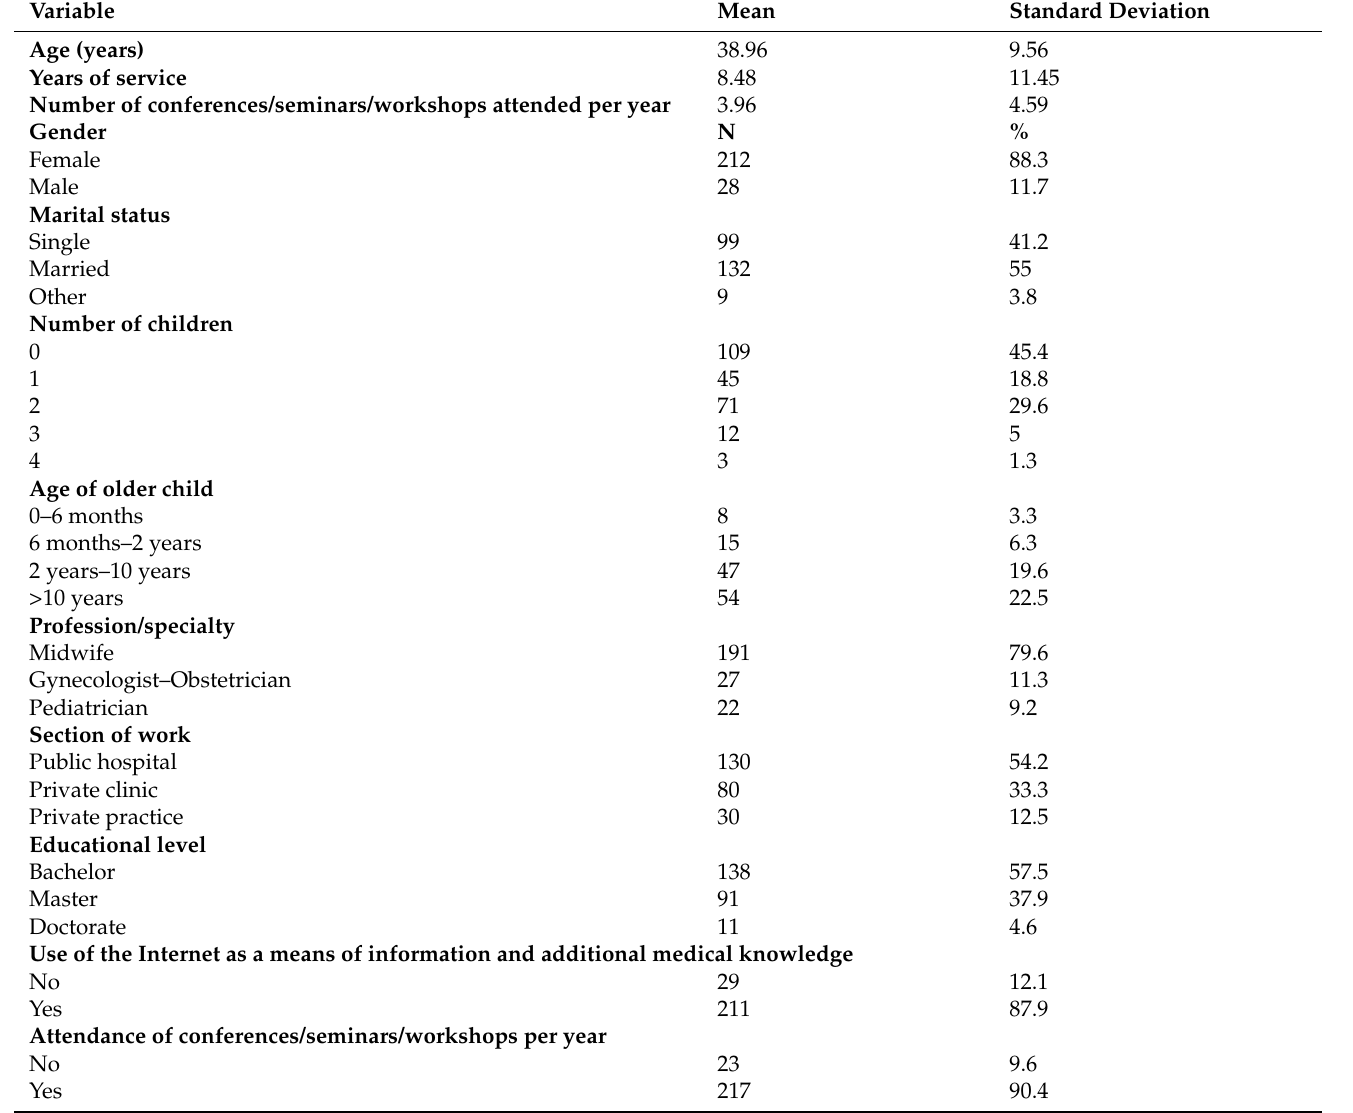
Table 1. Demographics of the study population.